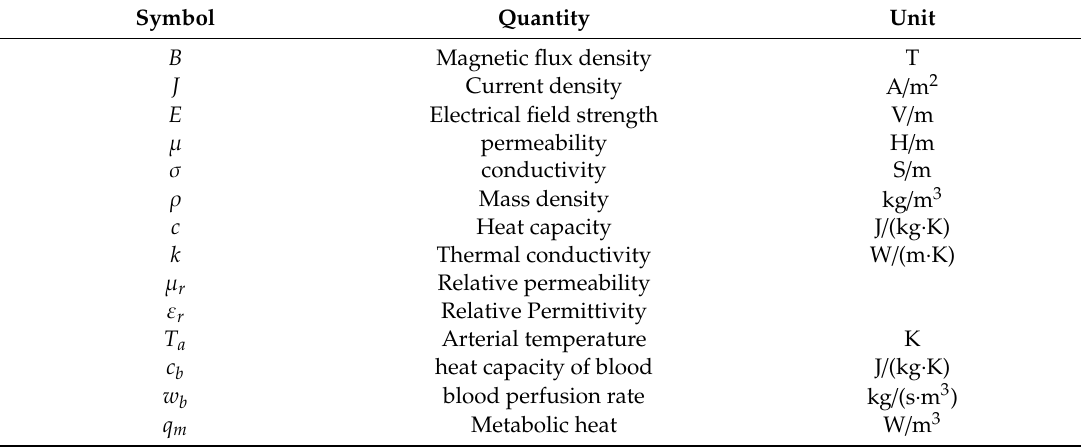
Table 1. Units for magnetic and heat